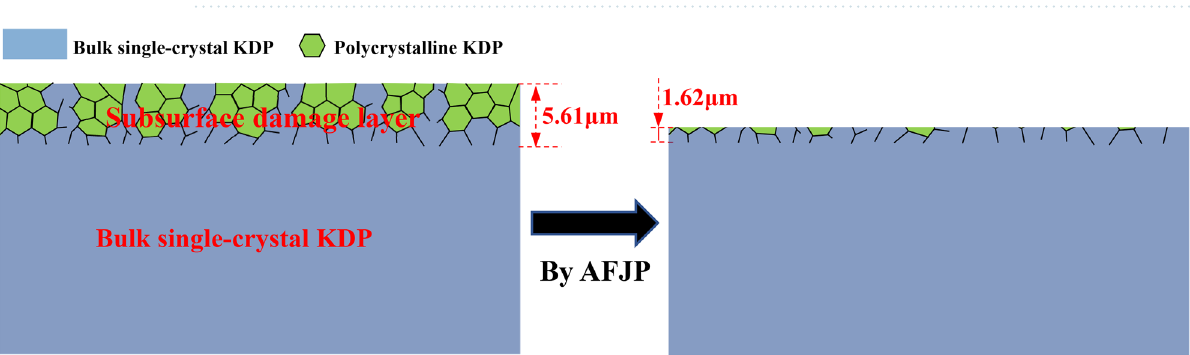
Figure 16. The GIXRD patterns of (010) SPDT surface of bulk single-crystal KDP after AFJP with increasing incident angle from 0° to 17°: ( a ) the low magnified image and ( b ) the high magnified image.